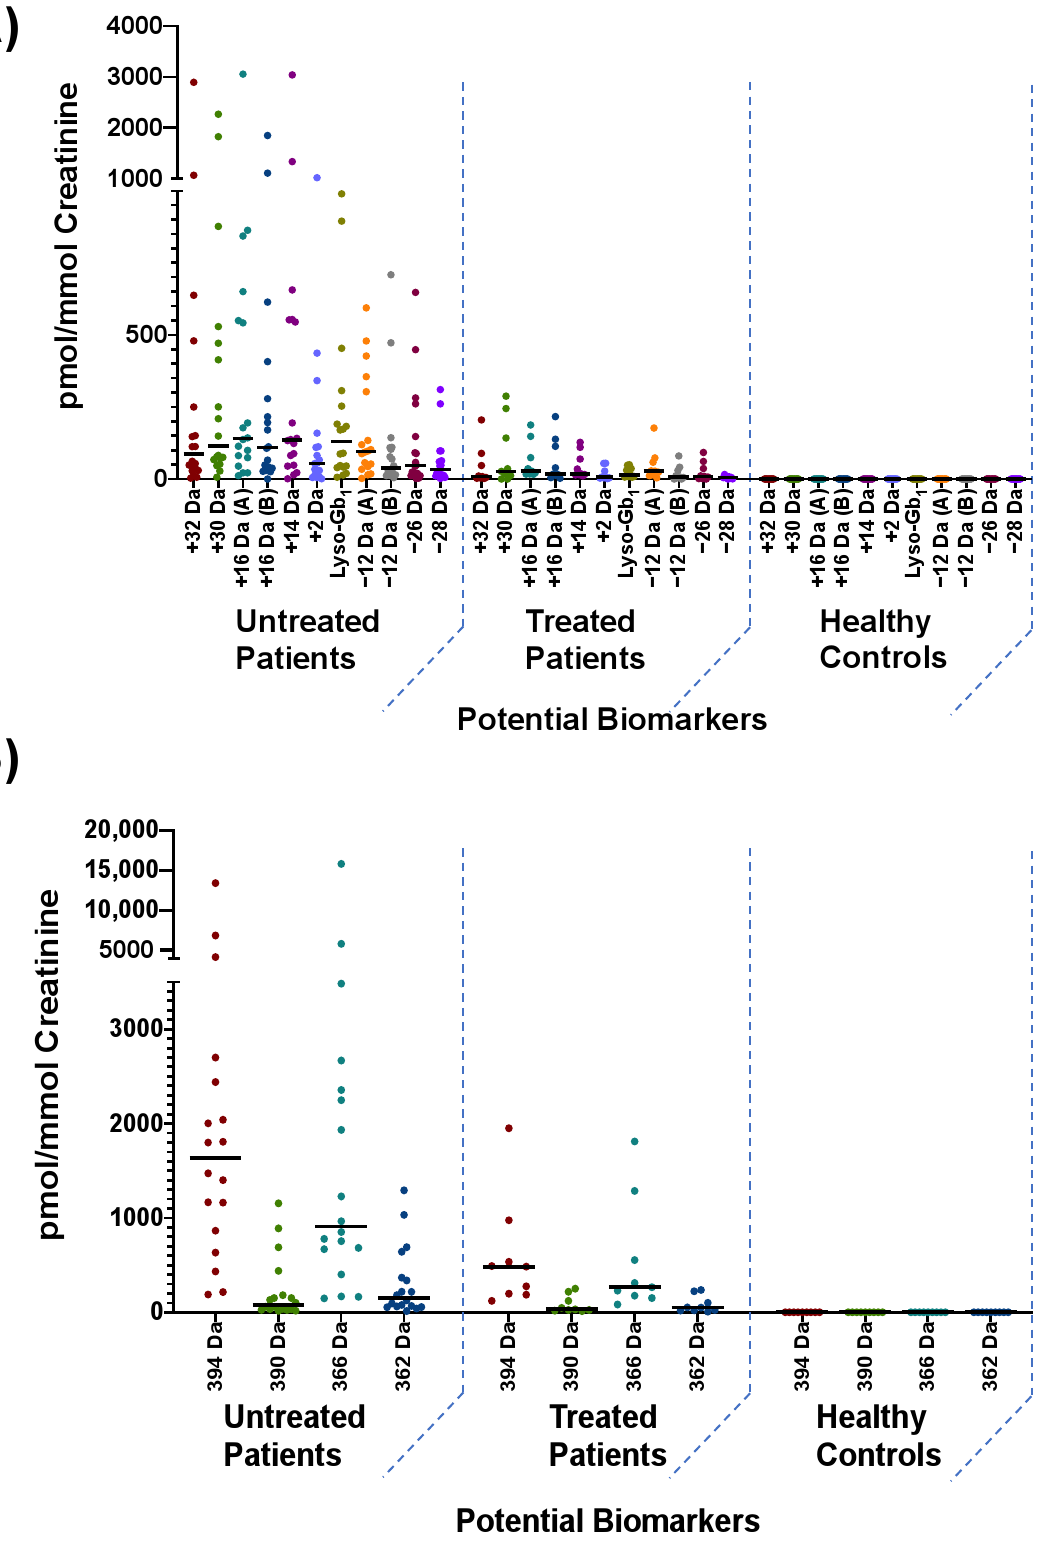
Figure 7. Distribution of: ( A ) lyso-Gb 1 and analogs +32, +30, +16 (A) and (B), +14, +2, − 12 (A) and (B), − 26, as well − 28 Da; and ( B ) Distribution of polycyclic analogs 394, 390, 366, and 362 Da in untreated ( n = 18), treated ( n = 9) and healthy controls ( n = 9). The median concentration for each potential biomarker in indicated by a horizontal black bar.